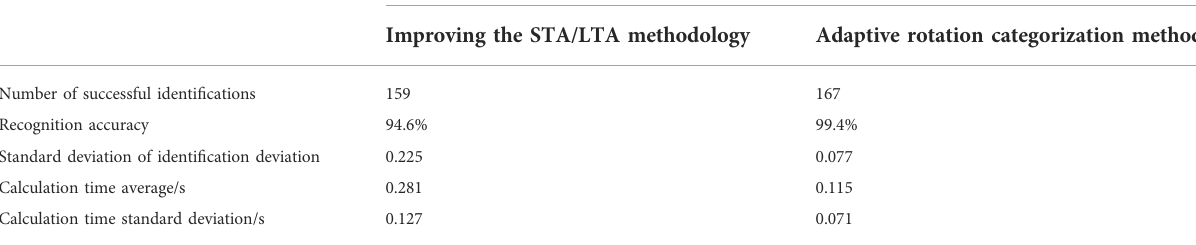
TABLE 2 Comparison of the microseismic phase identi fi cation effects for the two methods. Comparative